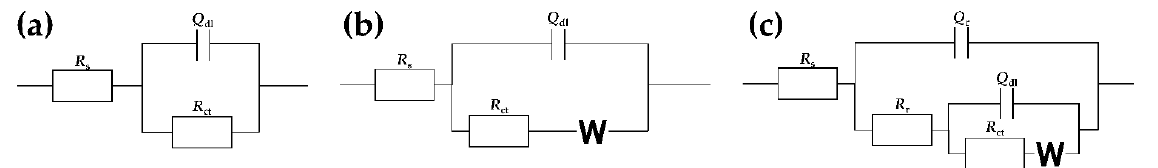
Figure 7. The equivalent electrical circuit for the EIS data: ( a ) blank; ( b ) 48 and 96 h; ( c ) 144, 288, 432, and 576 h. Table 5. Fitted EIS parameters for the specimens after different corrosion